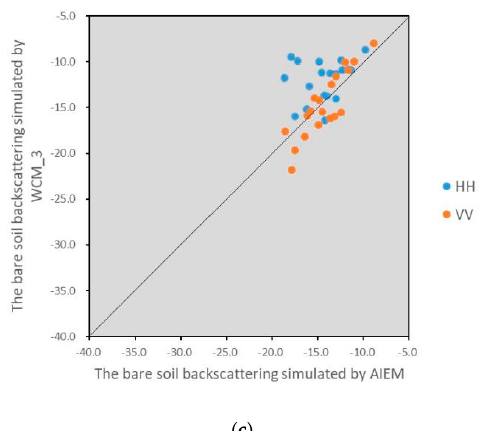
Figure 7. Scatter plots between the bare soil backscattering (dB) simulated by AIEM and three different water-cloud model strategies based on experimental data. The 1:1 line is included in the plot. ( a ) WCM_1; ( b ) WCM_2; ( c ) WCM_3.